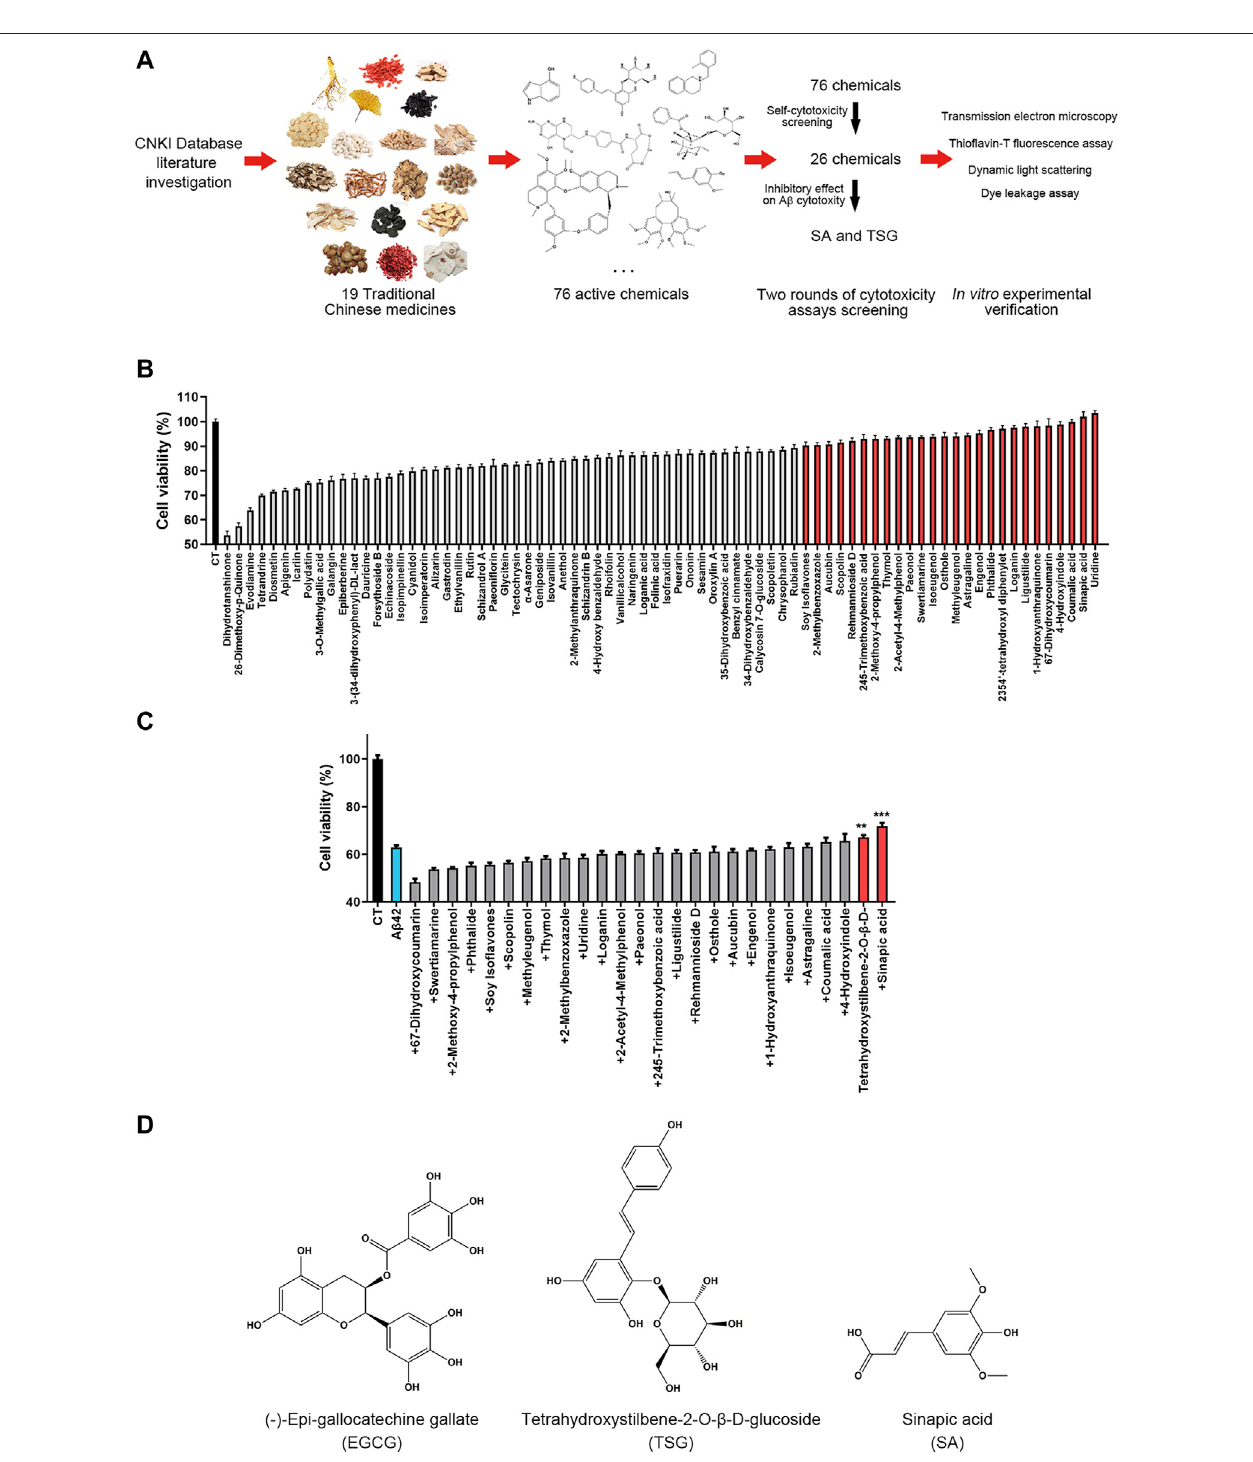
FIGURE 1 | Experimental design and chemical screening. (A) The experimental design of this article; (B) Screening the less toxic chemicals from all 76 chemicals, thechemicalswithminorcytotoxicity( < 10%)weremarkedred; (C) Screeningthechemicalsthatsigni fi cantlyinhibitthecytotoxicityofA β 42,thechemicalsthatinhibitthe cytotoxicity were marked red, **p < 0.01, ***p < 0.001; (D) The structure of (-)-epi-gallocatechine gallate (EGCG), Tetrahydroxystilbene-2-O- β -D-glucoside (TSG) and sinapic acid (SA).